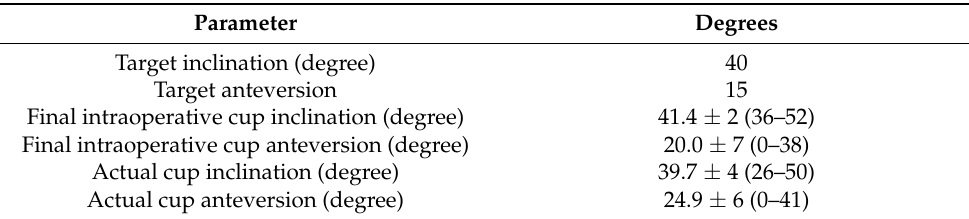
Table 2. Results of cup positioning: Intraoperativ values were assessed with PiGalileo registration system. Calculated 3D values were calculated with HipMatch software based on standard supine pelvic radiographs